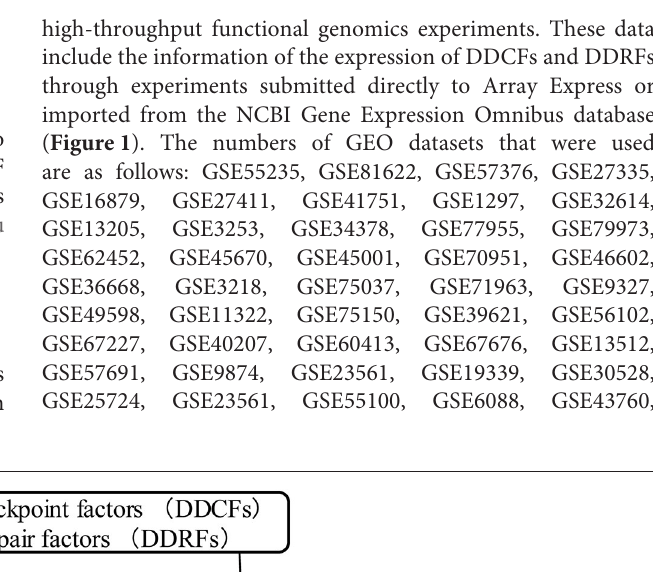
Frontiers in Physiology |